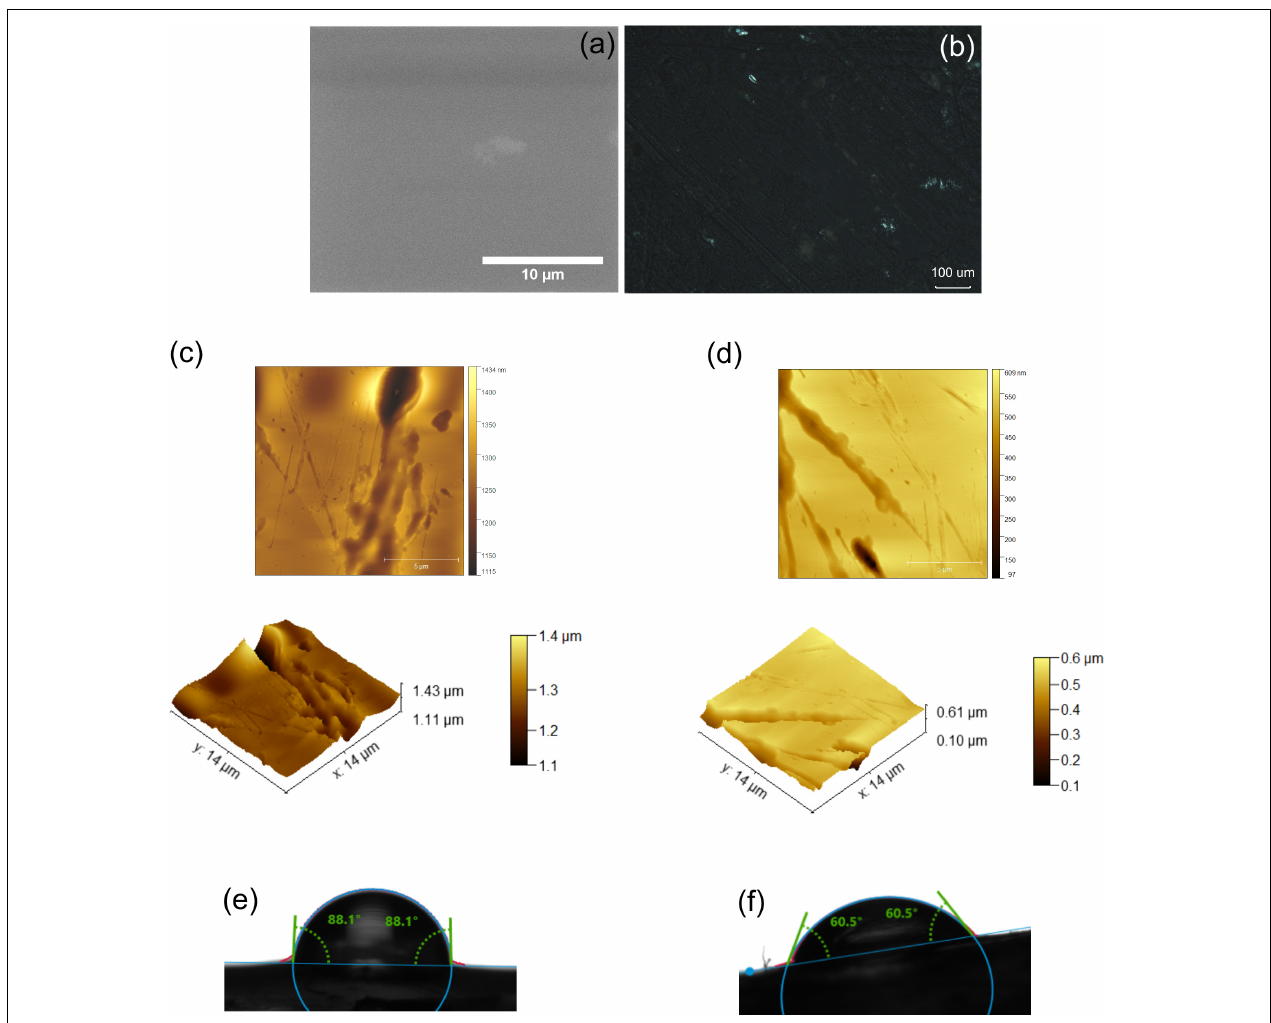
FIGURE 2 | SEM (a) and POM (crossed polarizers) (b) images of d-Ut(600) 10 LiCF 3 SO 3 [Bmim]Cl. AFM (topographical (top) and 3D-topographical (bottom)) images of d-Ut(600) 10 LiCF 3 SO 3 (c) and d-Ut(600) 10 LiCF 3 SO 3 [Bmim]Cl (d) . Selected photographs of static water contact angle measurements of d-Ut(600) ∞ (e) and d-Ut(600) 10 LiCF 3 SO 3 [Bmim]Cl (f) .